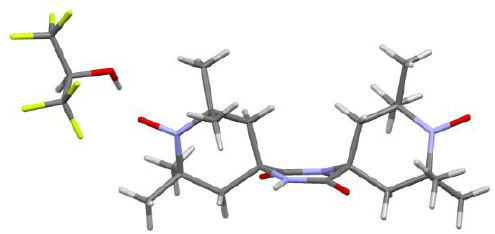
Figure 5. X-ray structure of dispirocyclic biradical 74 with a rigid diketopiperazine linker. A cocrystallized 1,1,1,3,3,3-hexafluoro-2-propanol (HFIP) molecule forms an H-bond between the N–O moiety and the hydroxy group of the solvent.